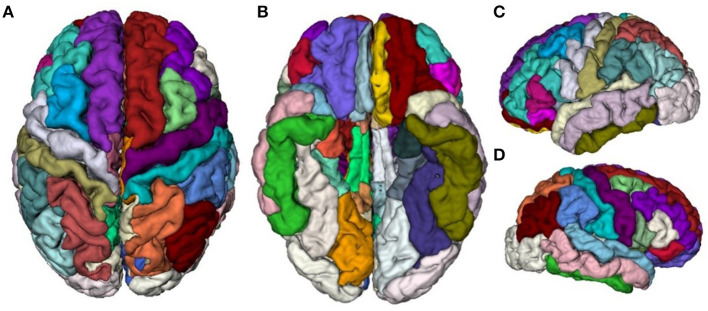
Visualization of the DKT40 cortical parcellation atlas, comprising 68 local regions. (A) Top view, (B) Bottom view, (C) Right view, and (D) Left view.